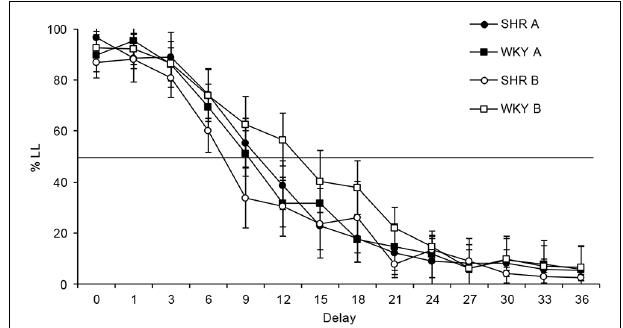
FIGURE 3 | Mean percentage of responses to the LL option in each delay. Black symbols depict data from Condition A, and white symbols from Condition B. Circles represent data from spontaneously hypertensive rats (SHRs) and squares from WKY. Vertical bars denote standard error of the mean.